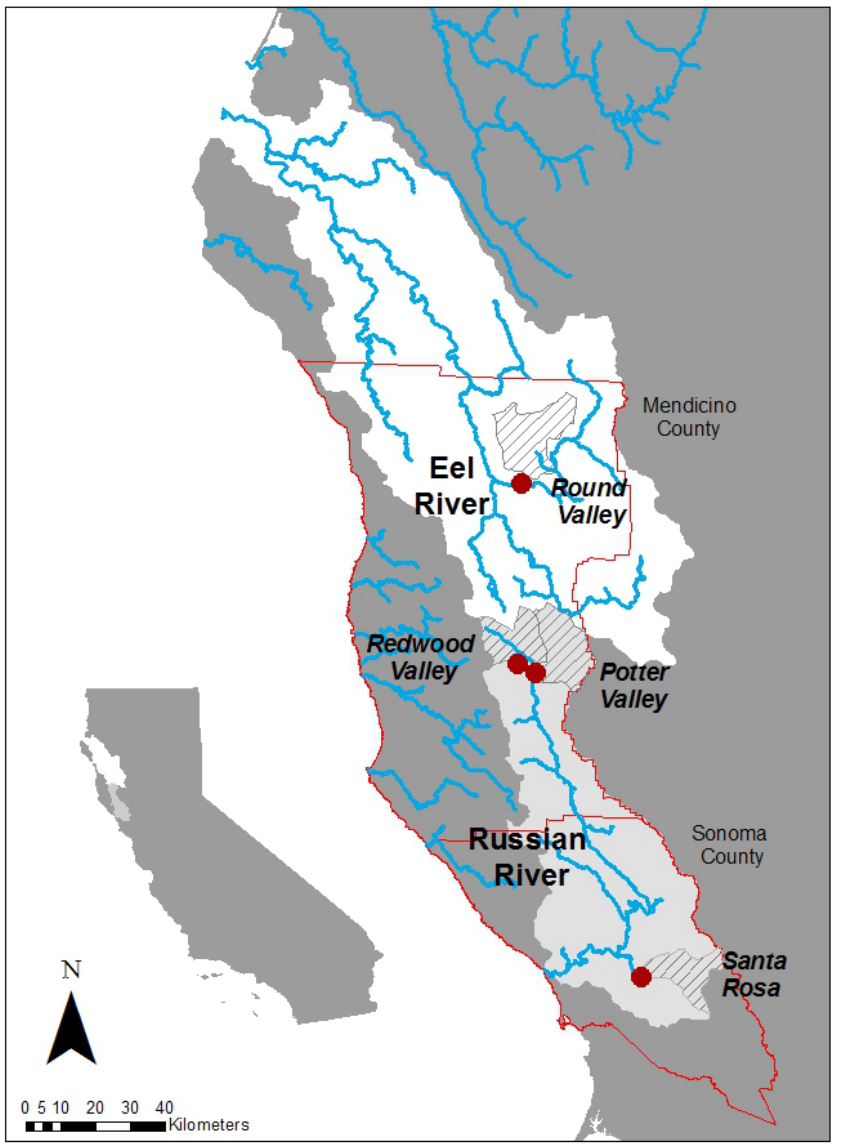
Fig. 1. Eel and Russian River Watersheds (adapted from Friends of the Eel. (online) URL: www.eelriver.